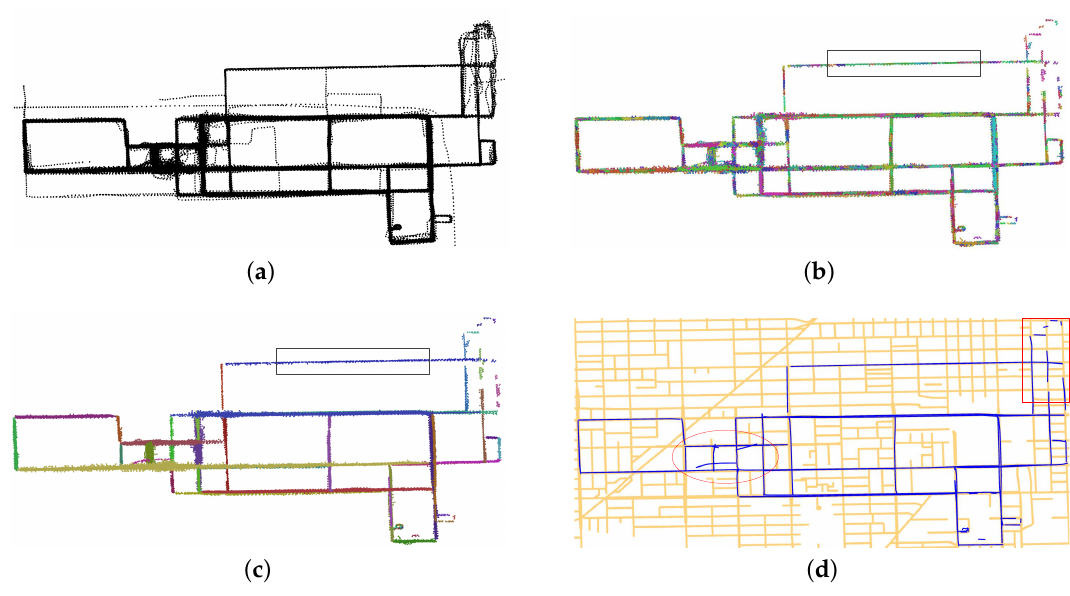
Figure 4. Experiment result of the Chicago dataset. ( a ) Raw GPS traces of the Chicago dataset displayed as points; ( b ) point clusters generated by the progressive Density-Based Spatial Clustering of Application with Noise (DBSCAN) algorithm with an orientation constraint; ( c ) point clusters after progressive grouping; ( d ) the generated road map (blue lines) overlapped with the ground truth map (yellow lines) of